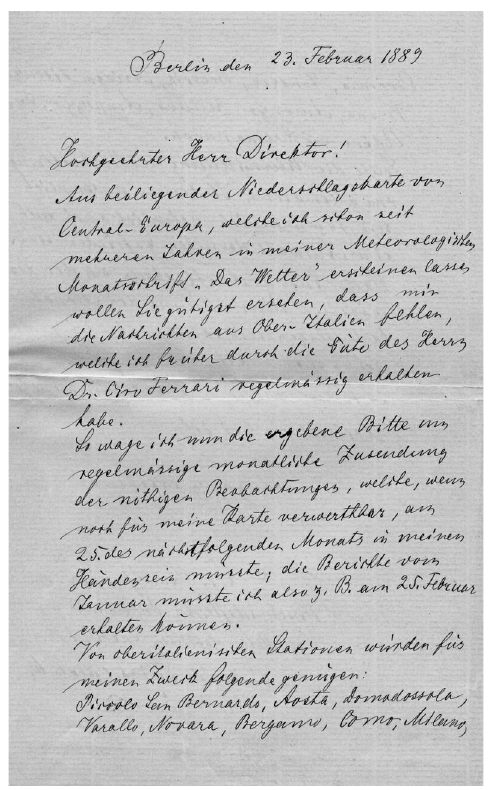
Fig. 9. Tacchini’s correspondence with german scholar.